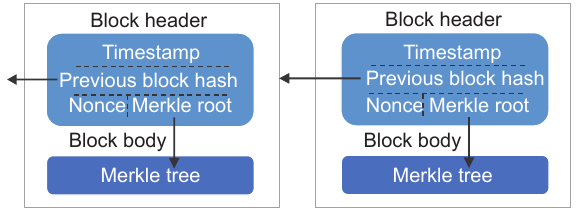
Fig. 3 A typical block structure in blockchain (e.g., Bitcoin